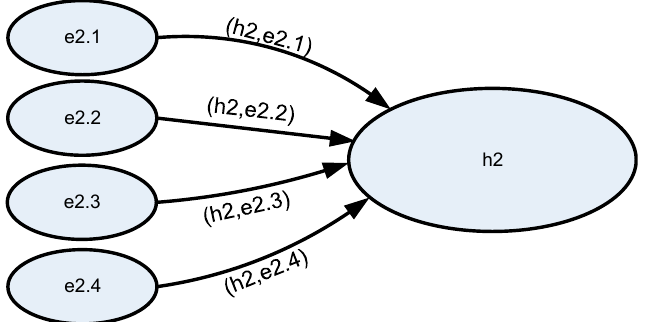
Figure 8. Model for the indirect hypothesis h1a, h1b, h3, h4, and h5.